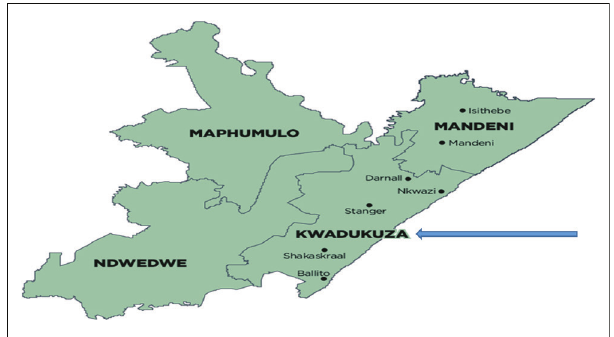
FIGURE 1: Location of KwaDukuza